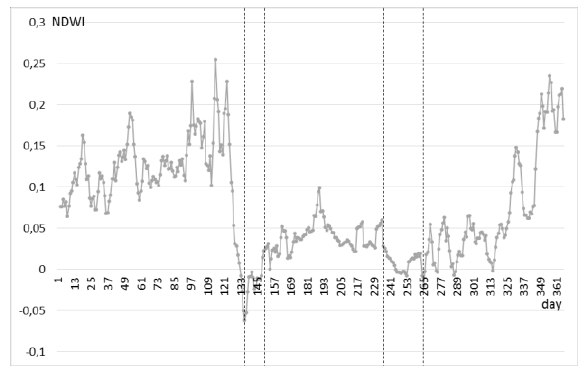
Figure 4. Annual NDWI graph of 2018 for the Ust’-Vym' meteorological station; values are averaged using 5-day sliding window; time frames of growing seasons are marked by dashed vertical lines Using growing season parameters (detected currently at the locations of meteorological stations), we are able to provide spatial interpolation and mapping of growing season dynamics (Fig. 5-10). In this way, spatial differentiation is reflected directly on the maps, while time dynamics can be observed using map series compiled for a number of